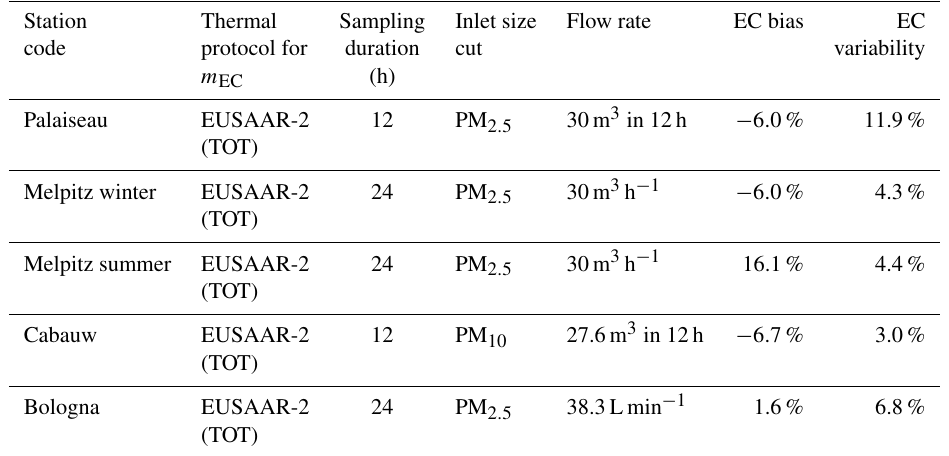
Table 2. Description of the methodology for EC mass concentration measurements: thermal protocol, sampling duration, inlet size cut, flow rate and performance during the ERLAP intercomparison, in relative terms for EC bias and variability (Sect. 2.2.3 and Eqs. S1 and S2).